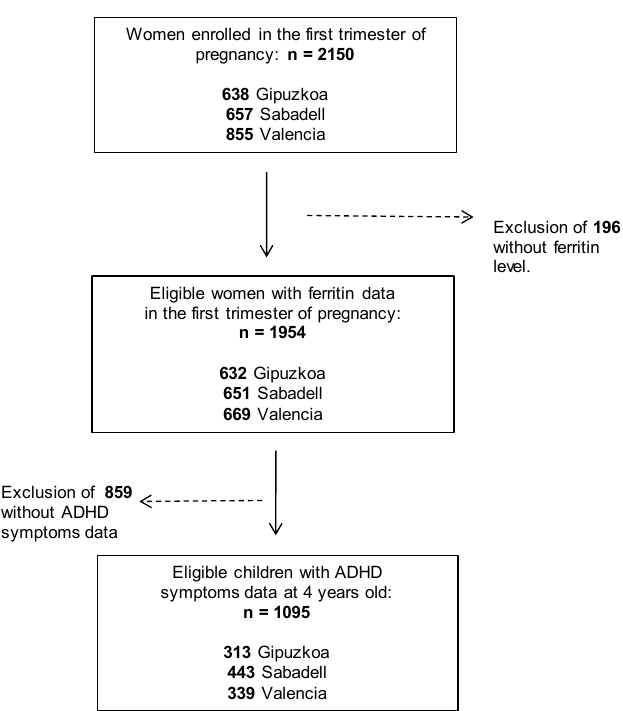
Figure 1. Maternal ferritin levels ( µ g / L) were assessed during the first trimester of pregnancy. The study was approved by the ethics committees of the centers involved in the study, and written informed consent was obtained from the parents of all